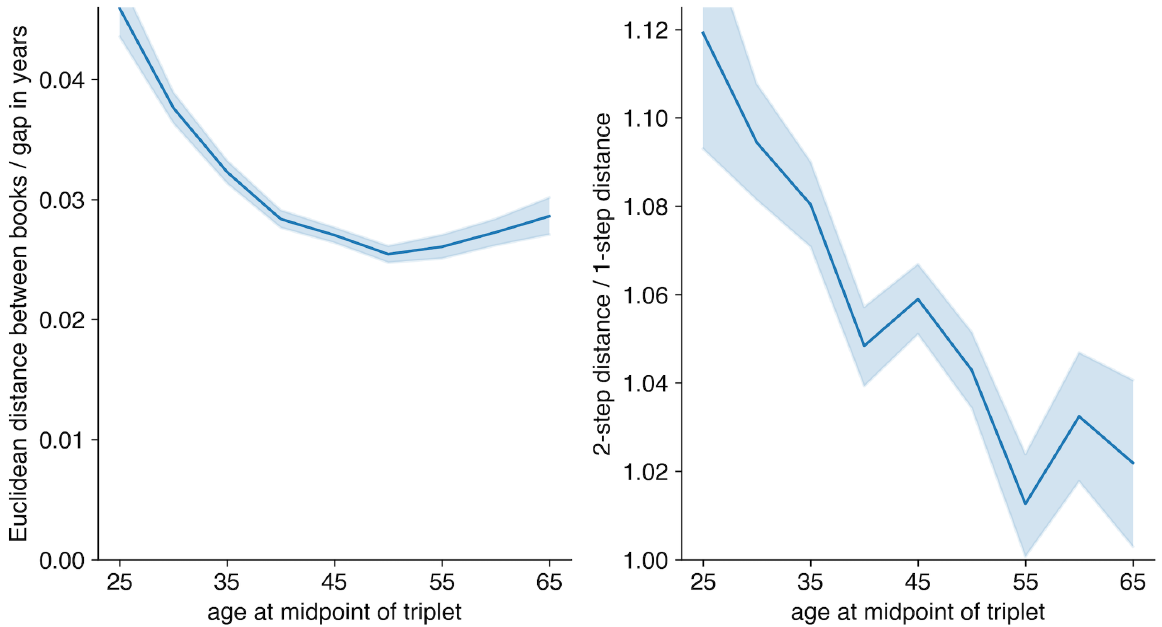
Figure 5: We repeatedly select three books sequential in our representation of an author’s career and measure the Euclidean distance between all three pairs in 200-dimensional topic space. The first subplot shows the mean distance from book 1 to book 3, divided by mean gap in years. The second subplot shows the mean distance from book 1 to book 3 as a multiple of the mean distance in the two single time steps (1 to 2 and 2 to 3); this measures the tendency for successive changes to move in the same direction. Distances are measured for 6,927 triplets resampled to give 1,714 authors equal weight; the shaded interval represents a 95 percent confidence interval from bootstrap